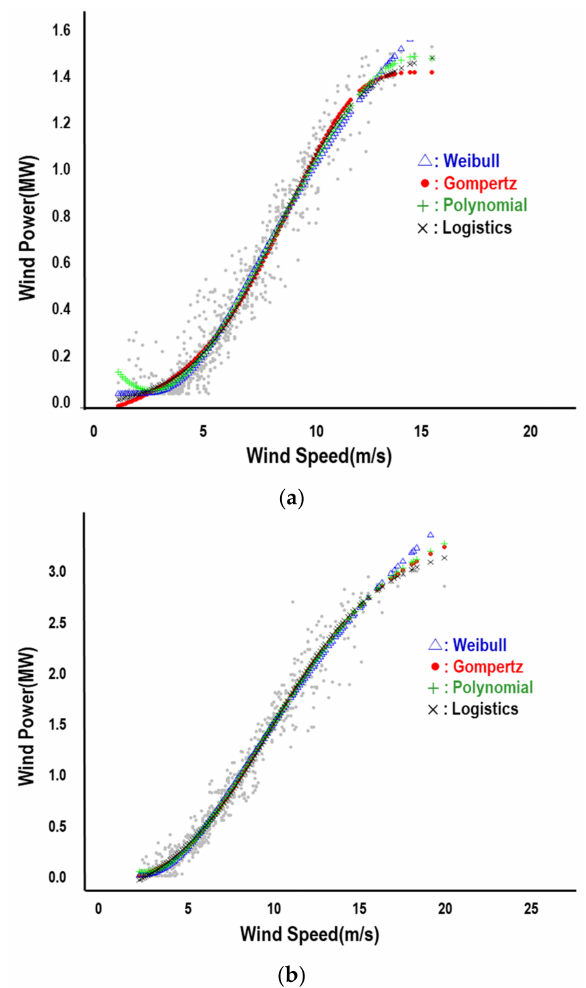
Figure 8. Fitted Functions of Power Curve with Refined Data. ( a ) 1.5 MW Wind Turbine; ( b ) 3.0 MW Wind